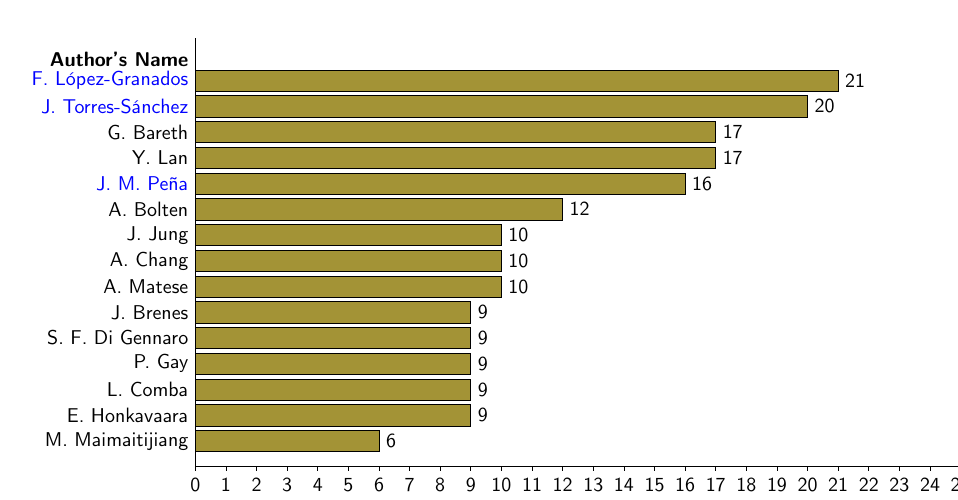
Figure 11. Most documents published by an author on adopting